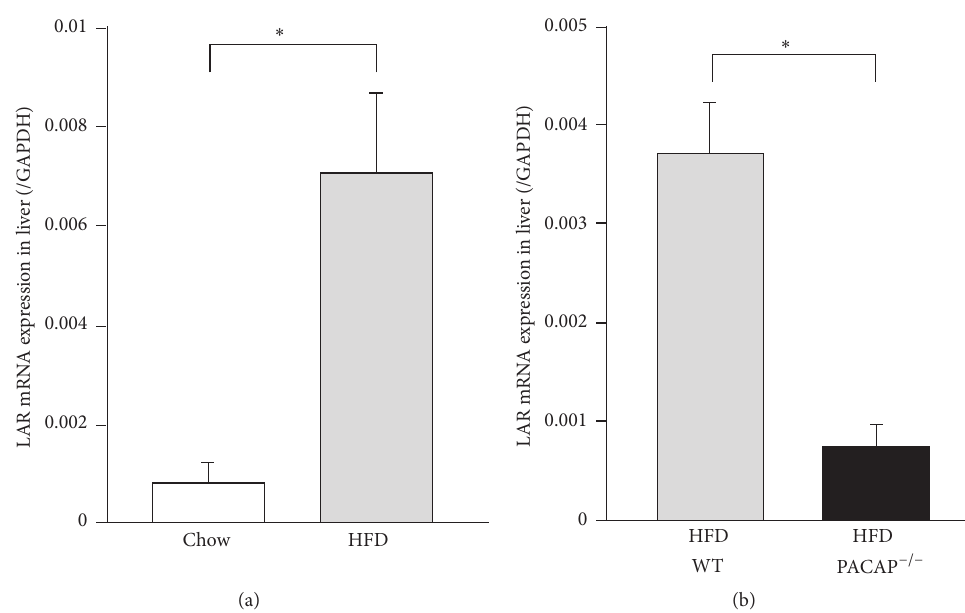
Figure 3: LAR expression in liver of mice. (a) LAR mRNA expression in the liver of regular chow fed and HFD fed ICR mice at 6 weeks. 𝑛 = 5 to 6. (b) LAR mRNA expression in the liver of wild type and PACAP null mice fed HFD for 6 weeks. 𝑛 = 5 to 6. All data are presented as means ± s.e.m. ∗ 𝑝 < 0.05